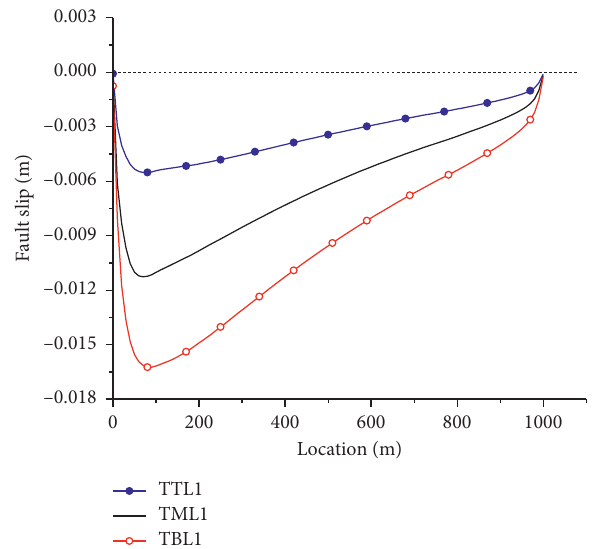
Figure 7: Fault slip along the fault plane when the fracturing region was TTl1, or TMl1, or TBl1.